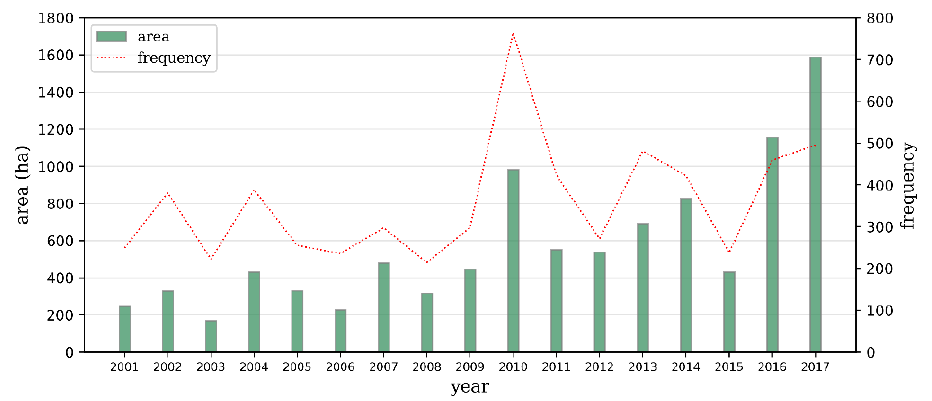
Figure 12. Changes over time in number of harvesting site representations (frequency) and total cut areas based on the FCLE map.